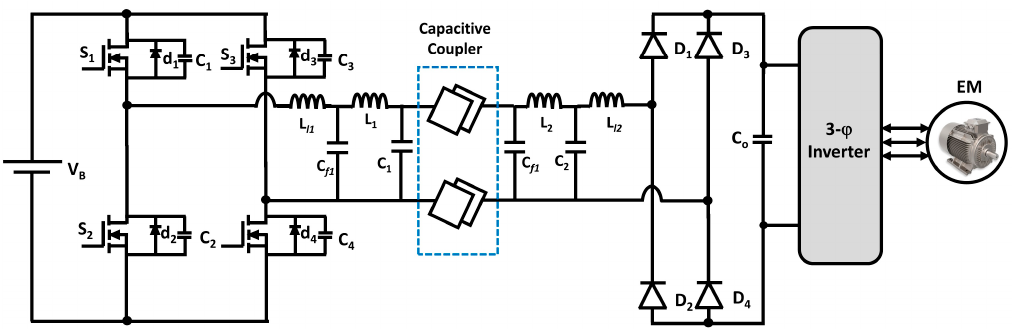
Figure 16. Capacitive WPT system with LCLC compensation topology [136].